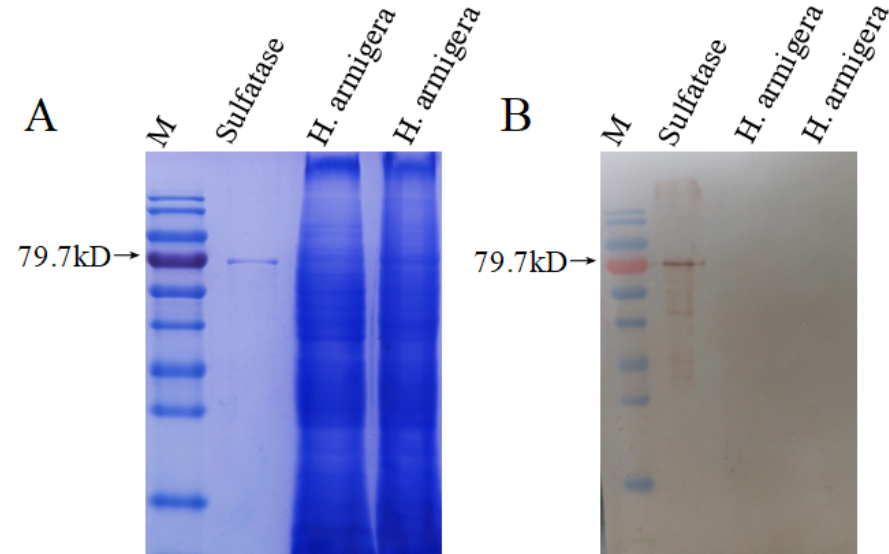
Figure 8. SDS-PAGE and Western blot analysis of sulfatase protein expressed in vitro and cotton bollworm protein. ( A ) SDS-PAGE analysis of sulfatase protein expressed in vitro and cotton bollworm protein; ( B ) Detection of sulfatase and cotton bollworm protein in vitro by Western blot analysis using anti-sulfatase antiserum. M: Protein marker.